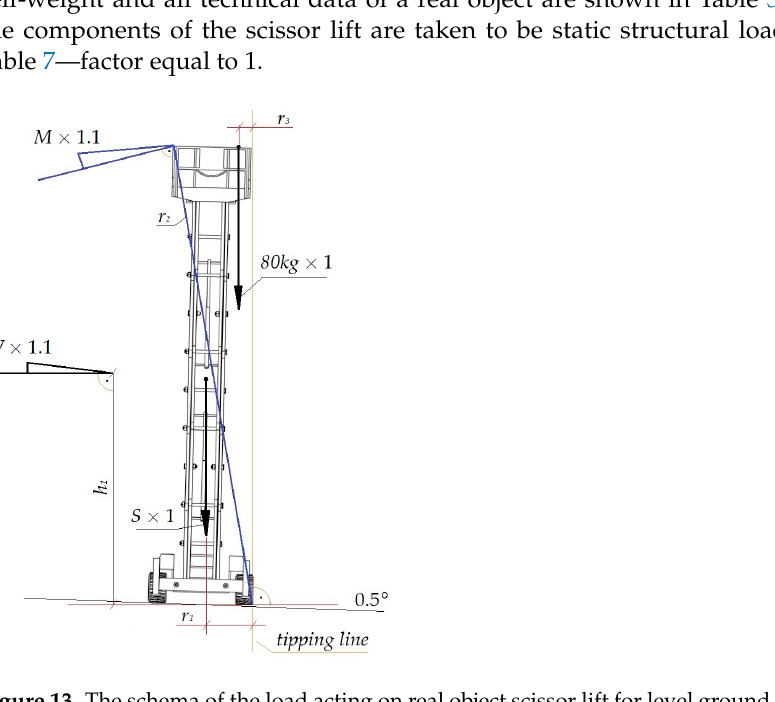
Figure 13. The schema of the load acting on real object scissor lift for level ground stationary example according to [17]. Table 7. The load and force directions for stability calculations for scissor lift